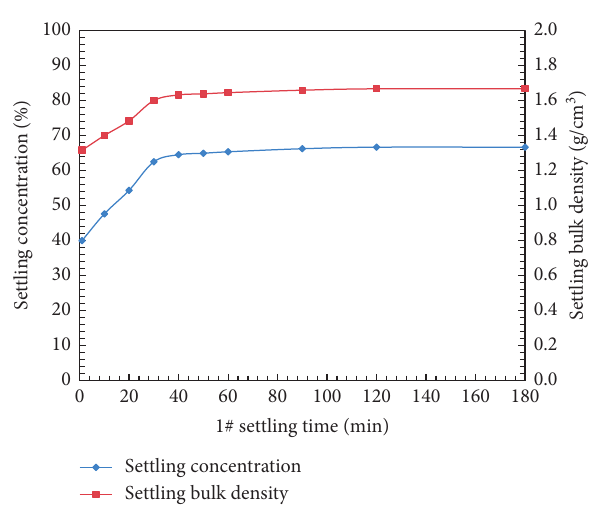
Figure 4: Variation curves of natural settling concentration and bulk density